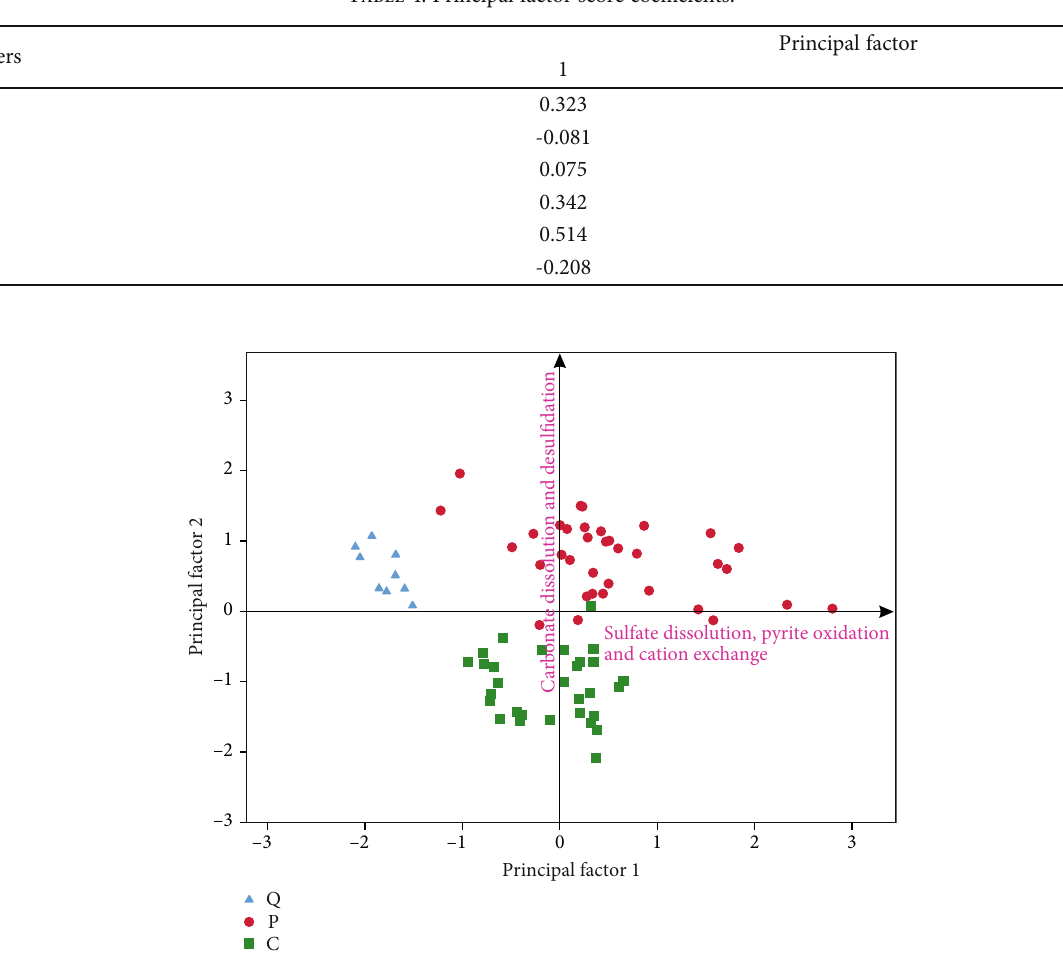
Figure 7: Scatter diagram with load scores from aquifer